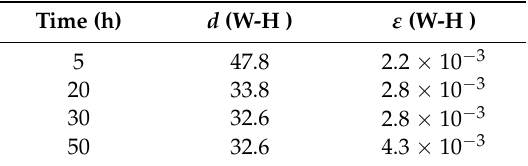
Table 1. Crystallite size (nm) and lattice strain of powder as functions of milling time (h), determined by the Williamson-Hall (W-H) method.